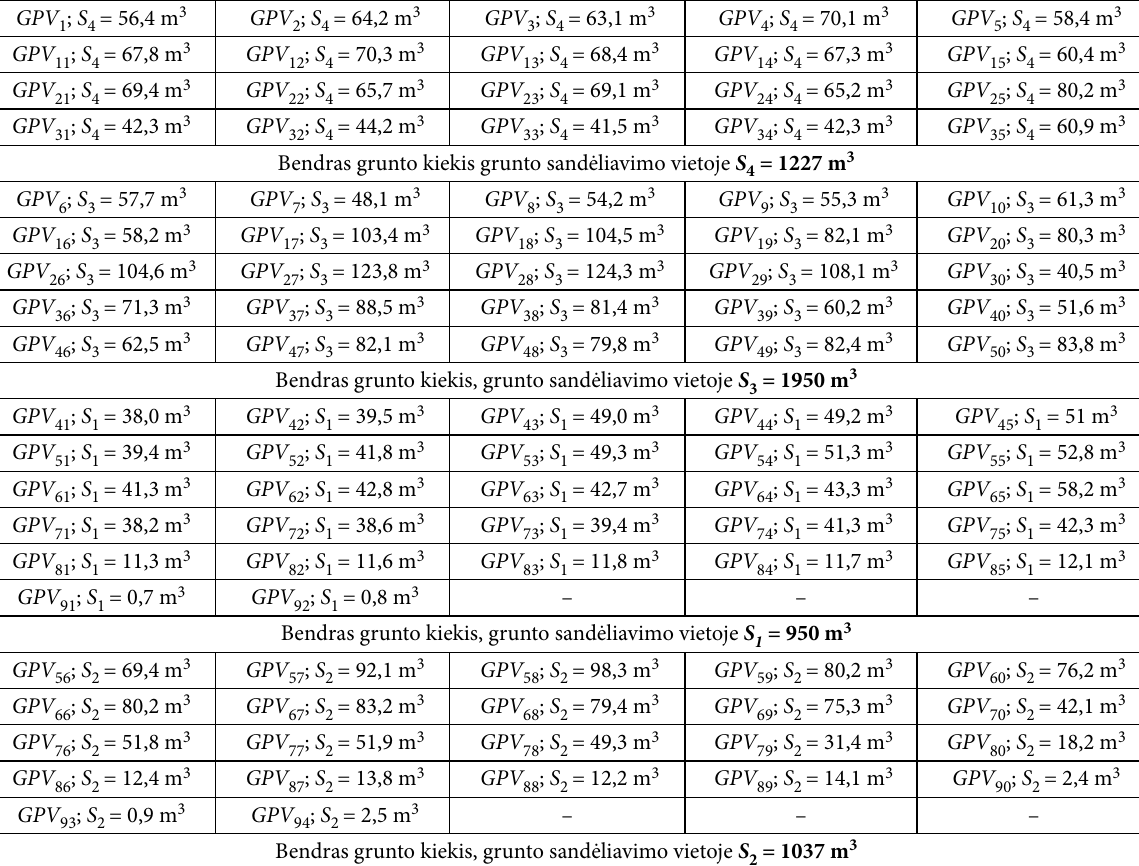
S – grunto sandėliavimo vieta statybos aikštelėje) Table 3. A rational plan for soil application on site